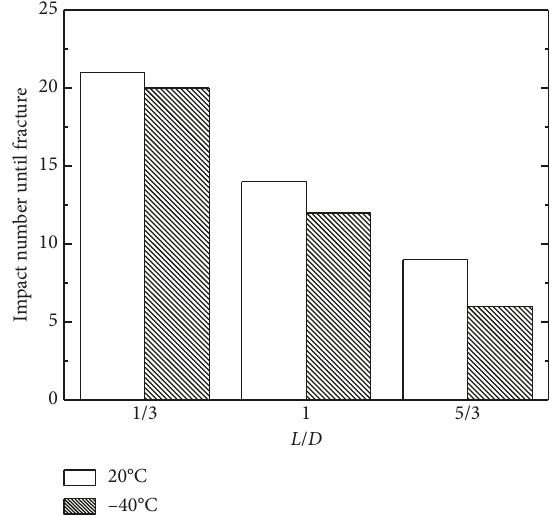
Figure 12: Threshold value of impact numbers until